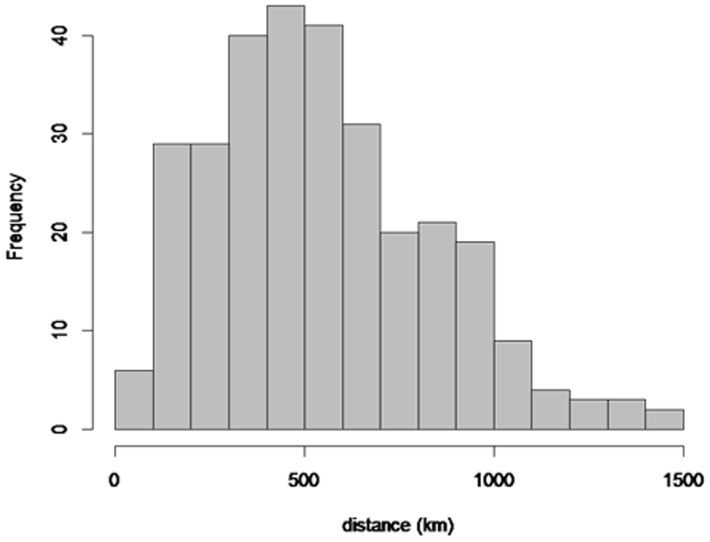
Pairwise distances between 25 Kenya and Tanzania lion population patches.Distance was calculated in kilometers, using data obtained during 2008–2010.